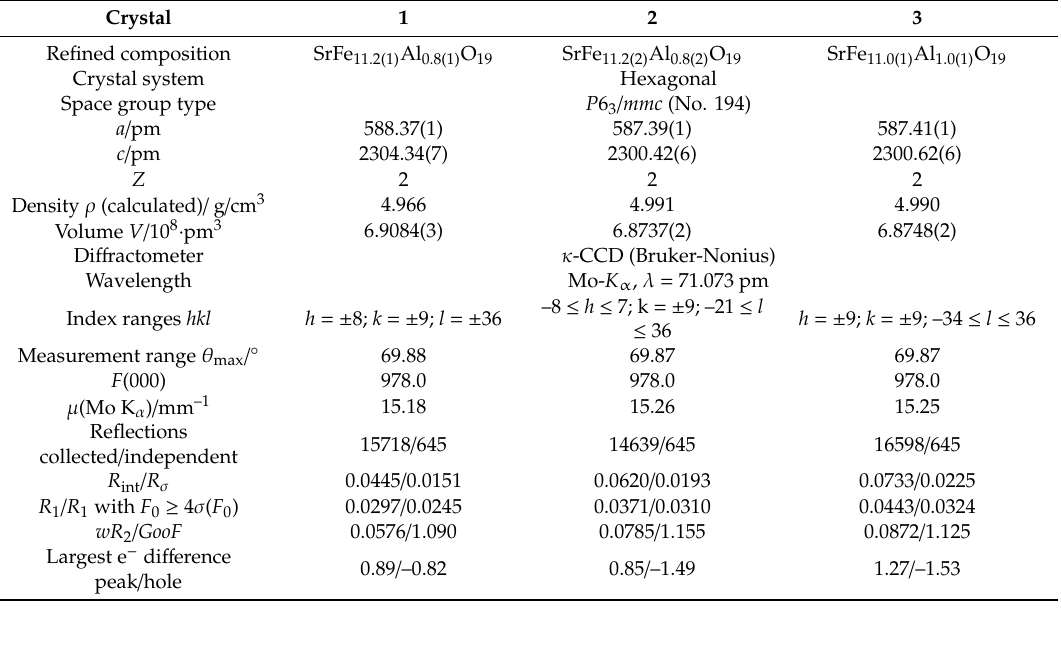
Table 1. Comparison of crystallographic data, refinement parameters and measurement conditions for crystals treated under di ff erent conditions.